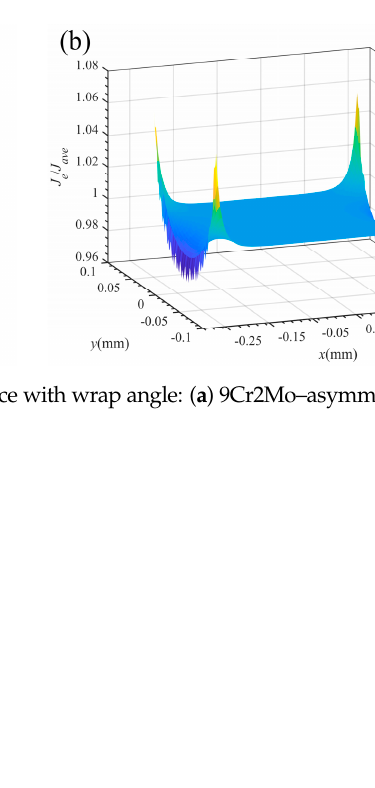
Figure 6. Variable coefficient of the J e / J ave simulation value in the electrical tensile with wrap angle.